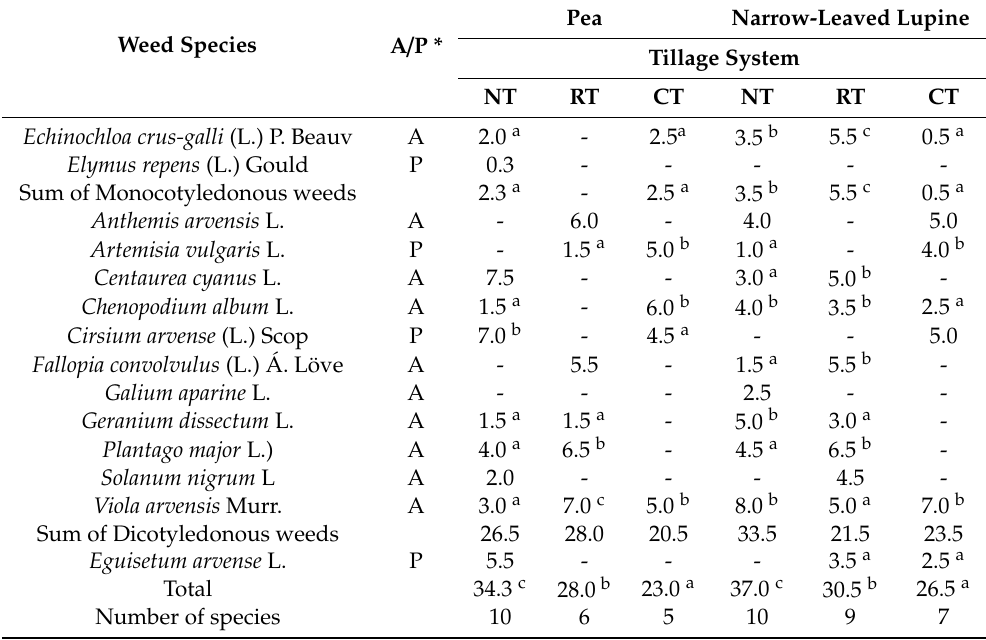
Table 5. Weed species composition in pea and lupine crop depending on tillage systems before harvest (plants · m − 2 ) (average for the years of